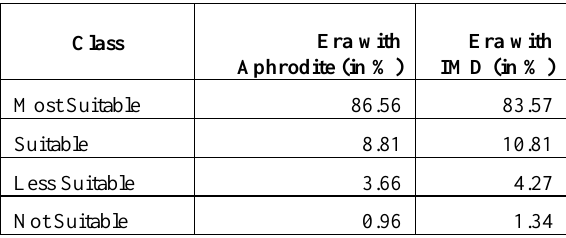
Table 7. Suitability in percent with reference